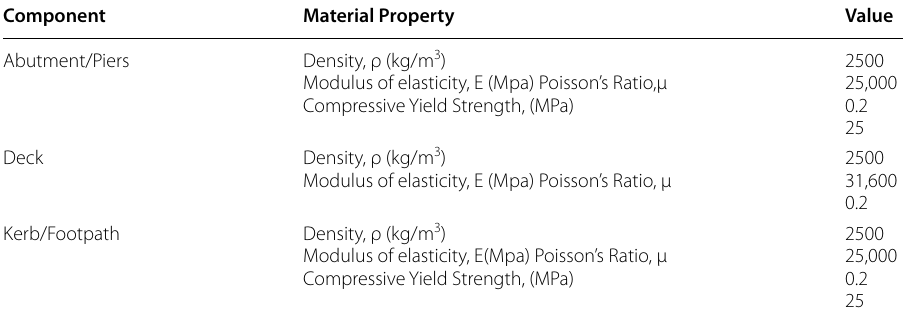
Table 5 Material Properties used in the 3D FEM model of the Bridge Component Component